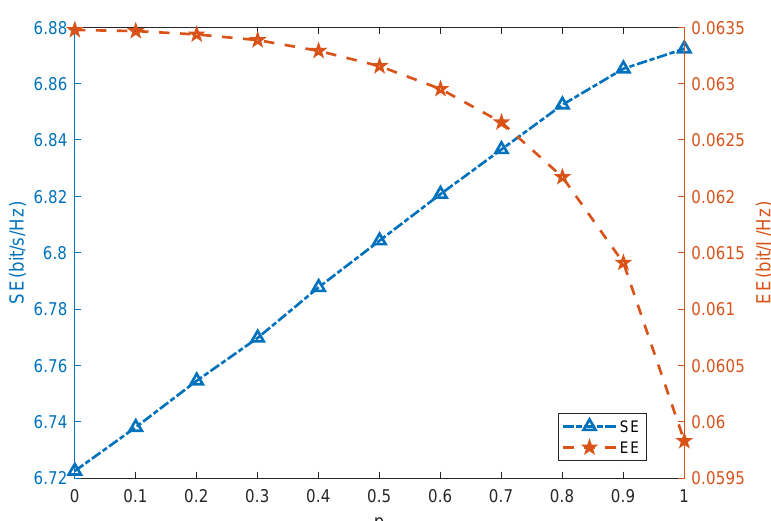
Figure 8. The optimal radius vs. ρ .